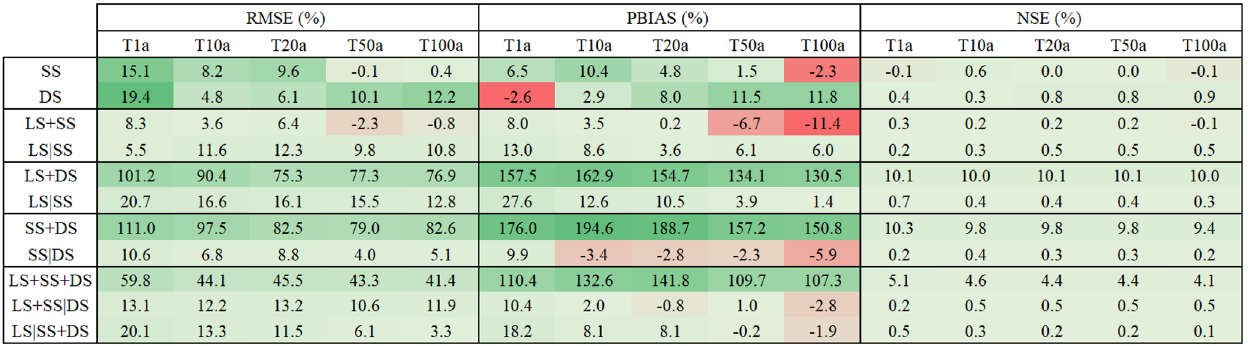
Table 9. Median difference between kriging and index-based improvements calculated for different data as per Eq. (15). The median is computed from 133 stations. The data used as input are short series (SS), long series (LS) and disaggregated daily series (DS) and com- bined either with same importance ( + ) or with priority importance ( | ). The positive difference shown in green shades indicates that kriging introduces bigger improvements towards the benchmark than the index-based regionalisation. The negative differences shown in red shades indicate that the index-based regionalisation has the bigger